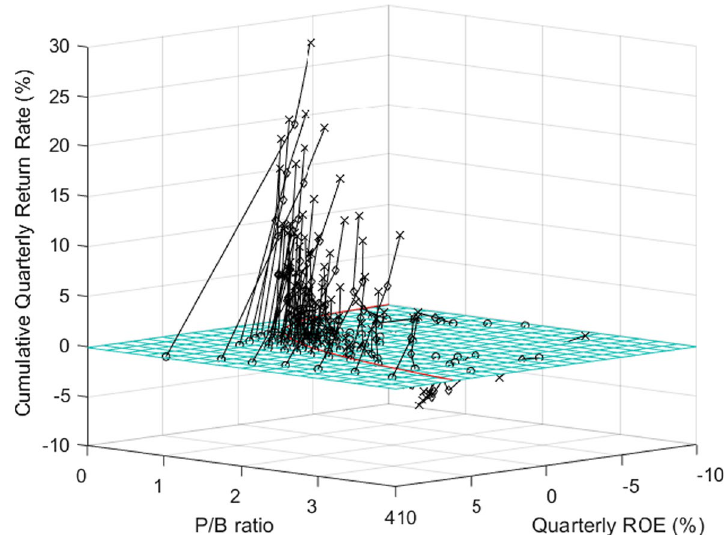
Fig. 25 The relationships among ROE, P/B, and cumulative quarterly return rates (circle, diamond, x‑mark: the data in the t, t 1, t 2 + +